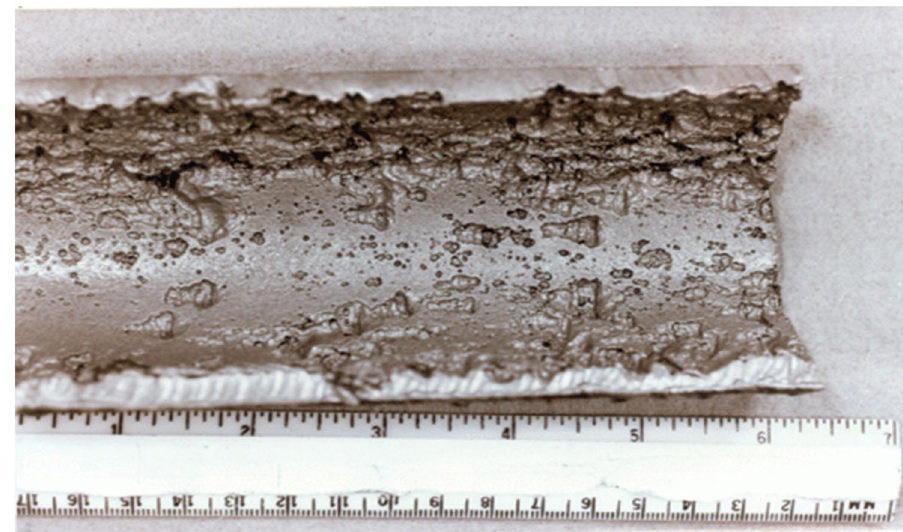
Fig. 7 Example of the cor- rosions occurred on the well materials, after been exposed with CO 2 with the presence of